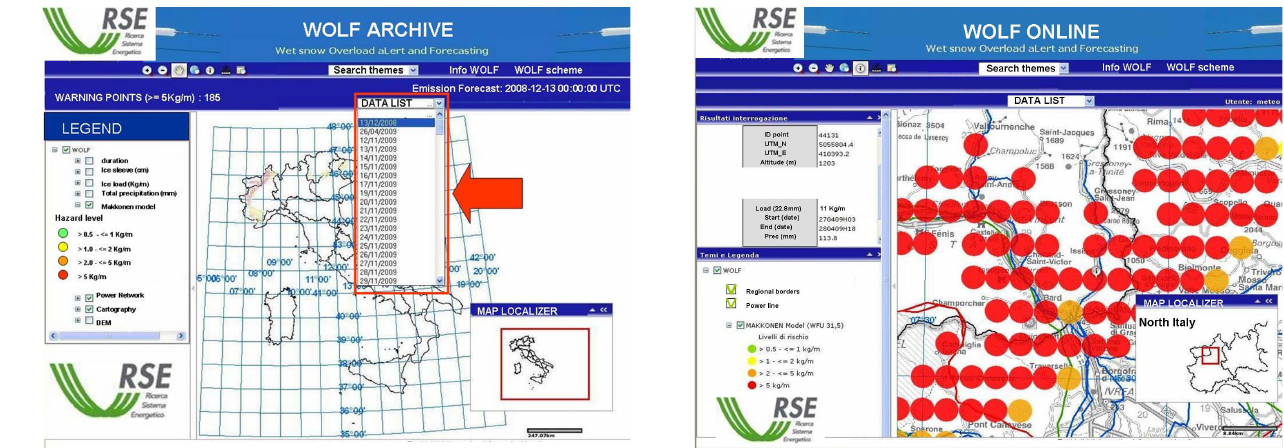
Fig. 7. Web-GIS Archive tool: it is possible to download and visu- alize each event stored in the Archive, through the data list menu.